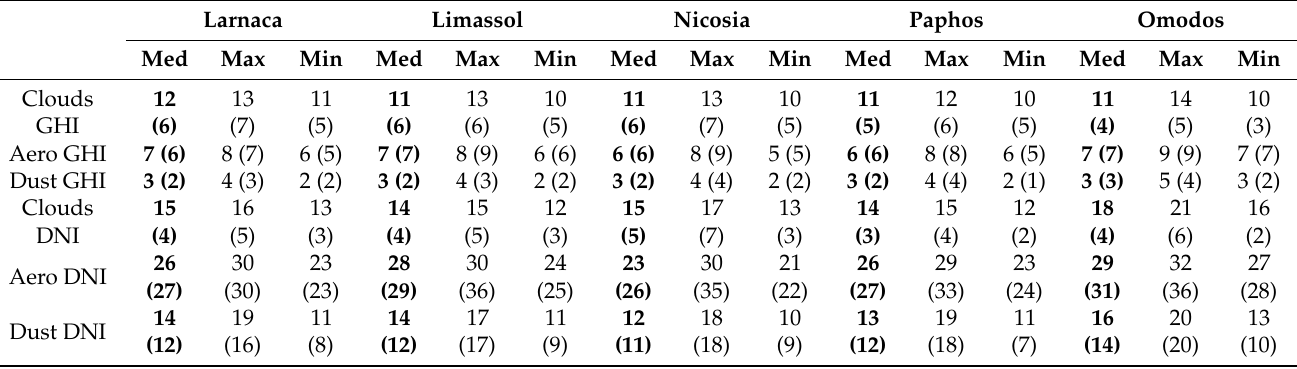
Figure 6. Attenuation (in %) of the total annual GHI (left column) and DNI (right column) by aerosols (upper row), dust aerosols (middle row), and clouds (lower row). Table 4. Median, minimum, and maximum attenuation (in %) of annual GHI and DNI by aerosols and clouds. The corresponding numbers for summer are given in the